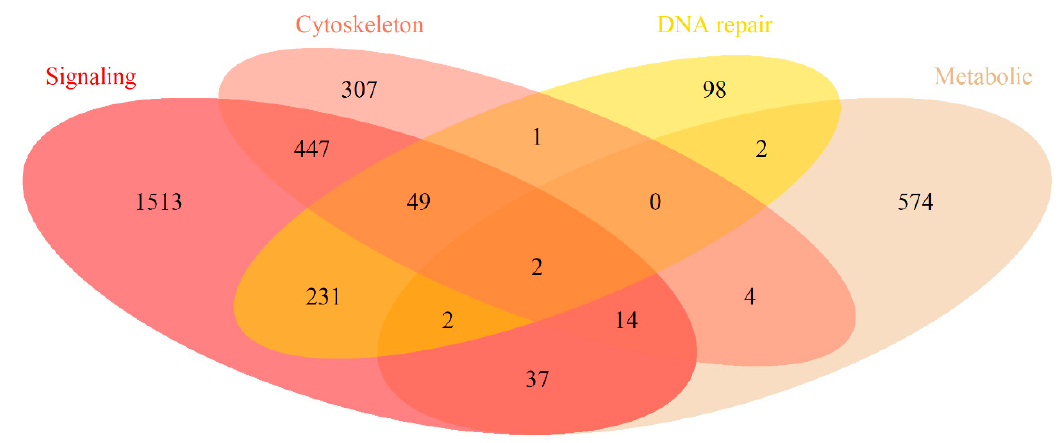
Figure 3. Percentage share in different cancer types of genes belonging to four groups of molecular pathways: ( A ) cytoskeleton, ( B ) DNA repair, ( C ) metabolic, ( D ) signaling pathways. Color represents cancer type. Color density is proportionate to number of mutant genes per group per decile. Point width reflects number of samples in cancer type.